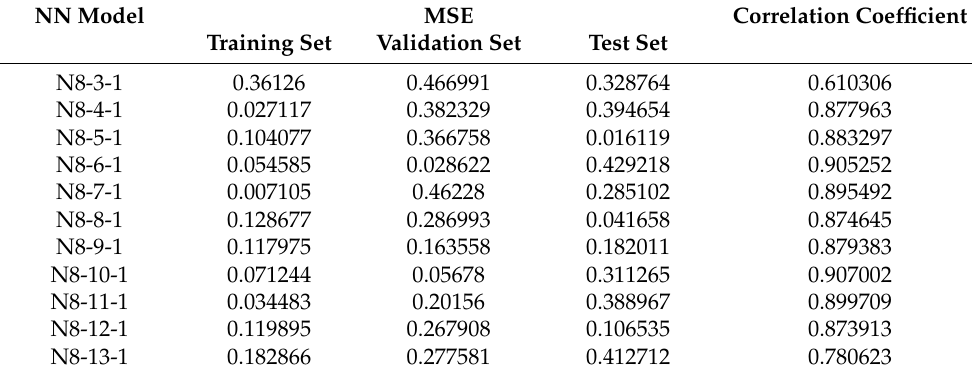
Table 3. Performance value of Failure